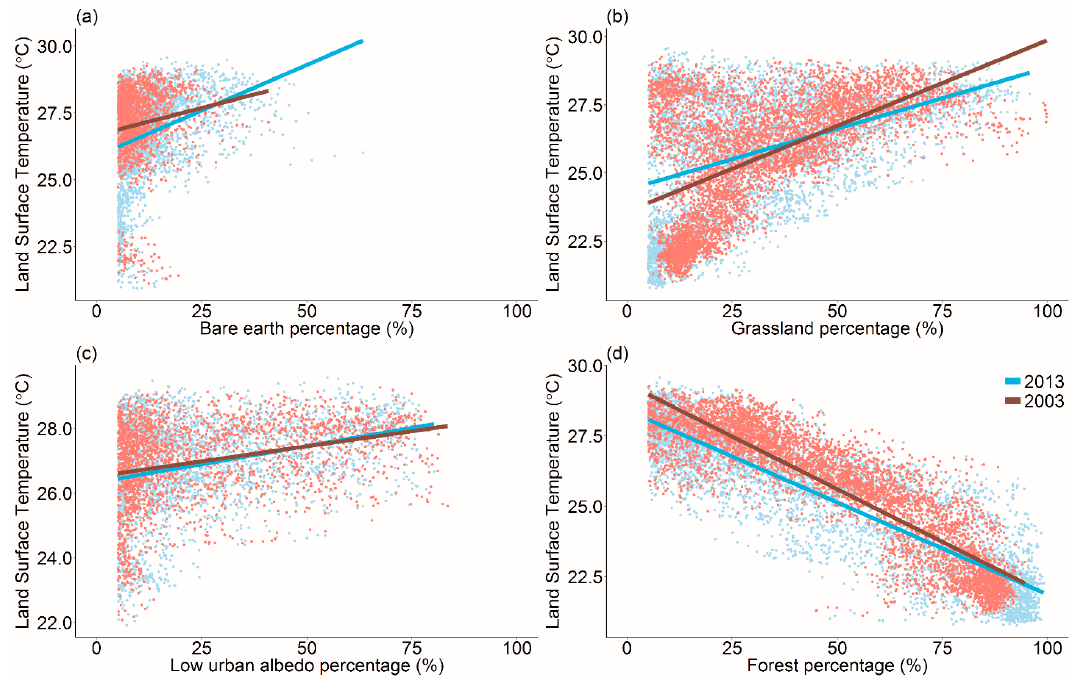
Figure 4. The 2003 and 2013 percentage land cover within a MODIS pixel and the average annual daytime LST in 2003 and 2013 for: ( a ) Bare earth ( b ) Grassland ( c ) Low urban albedo and ( d ) Forest, with points (lighter colours) representing individual values of each year. All linear trends are statistically significant at p < 0.05.